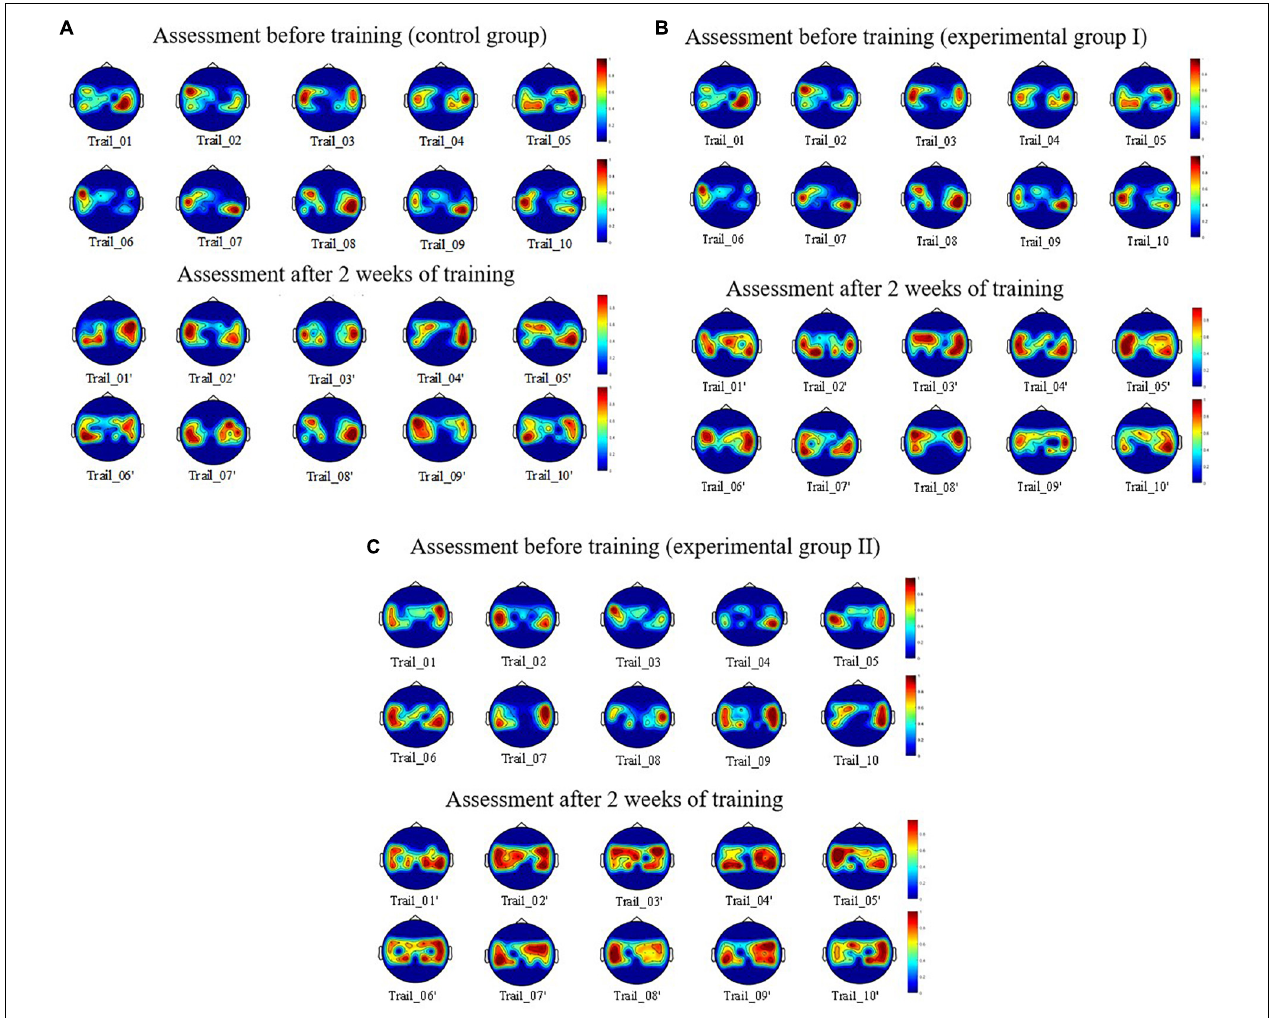
FIGURE 7 | Spatial distribution of the brain activation between the before and after enhanced MI training. (A) For control group. (B) For experimental group. (C) For experimental group